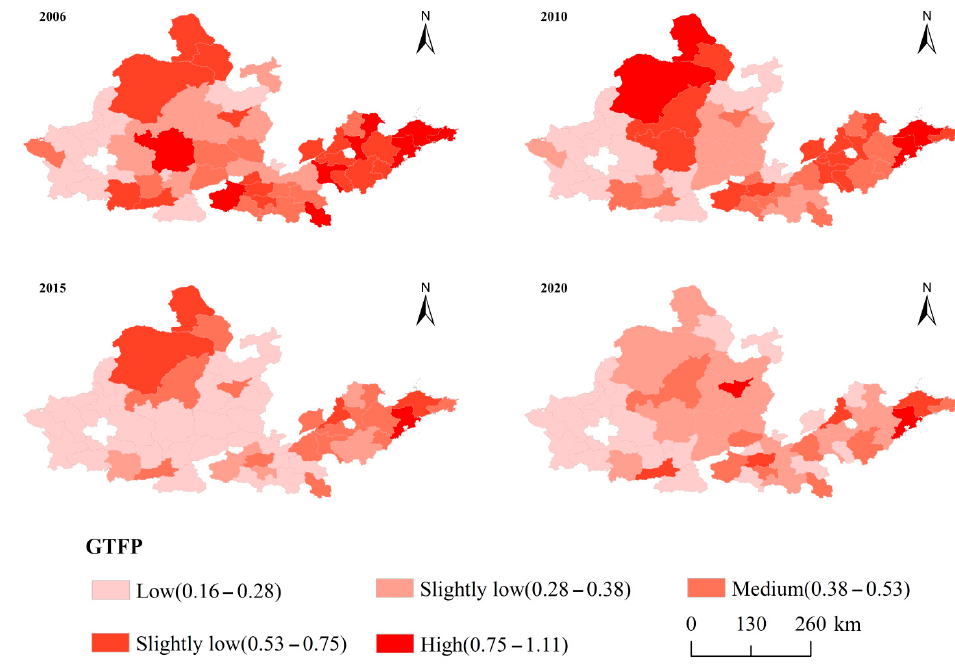
Figure 2. Spatial differentiation of the urban GTFP in the YRB.